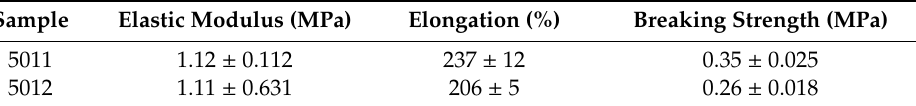
Table 4. Mechanical property parameters of coatings.